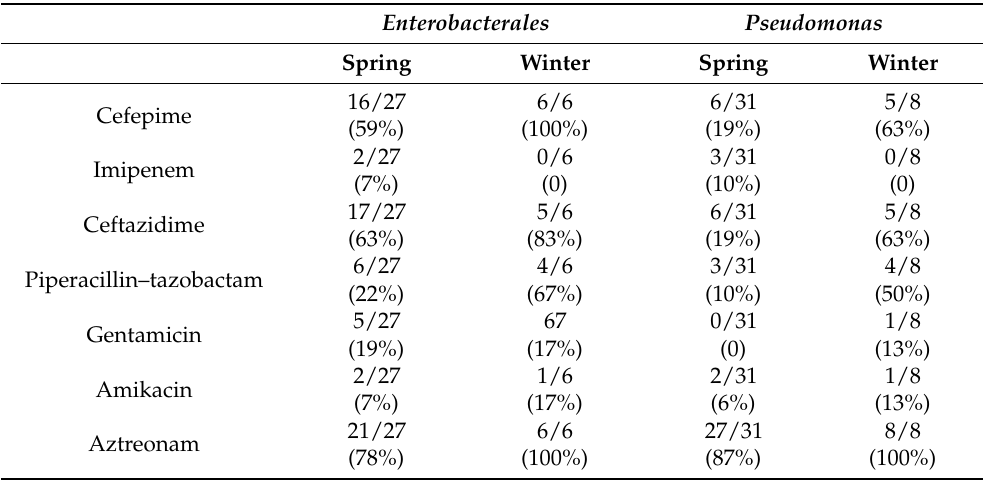
Table 2. Resistance of the tested Enterobacterales and Pseudomonas species: numbers indicate the number of strains resistant out of the strains tested